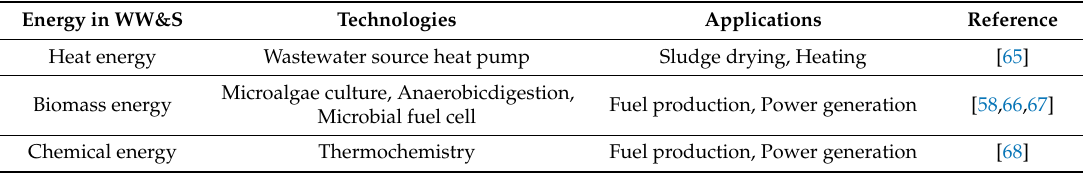
Table 3. S ome available energy and utilization ways in WW&S.